Question: Does the figure show an increasing or a decreasing trend?
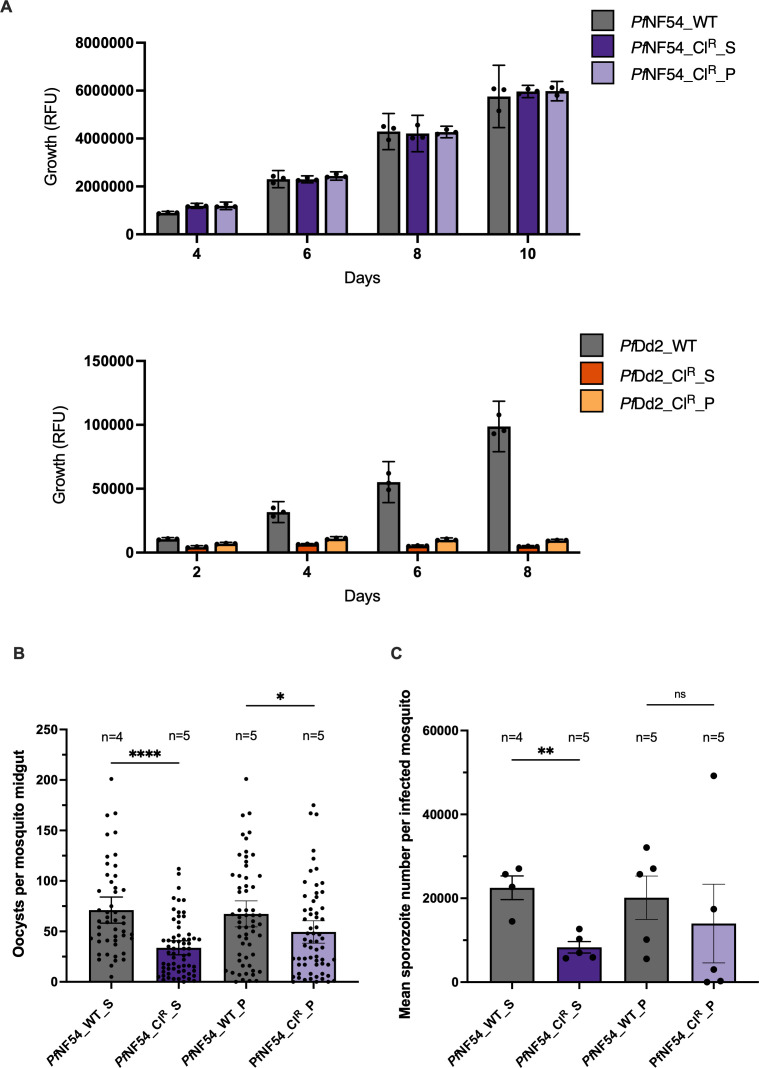
Answer: increasing